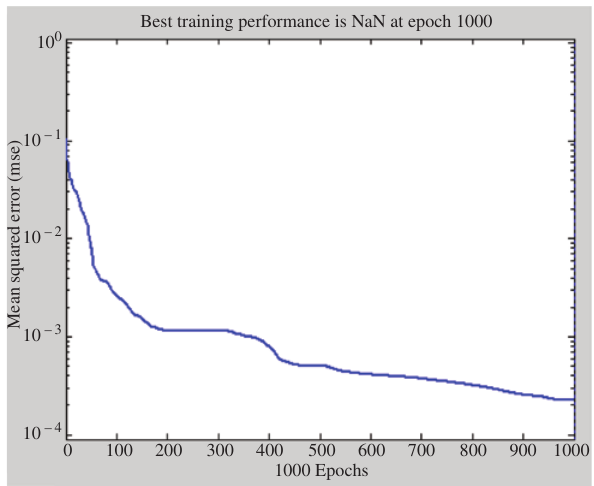
Figure 13: Performance Plot for